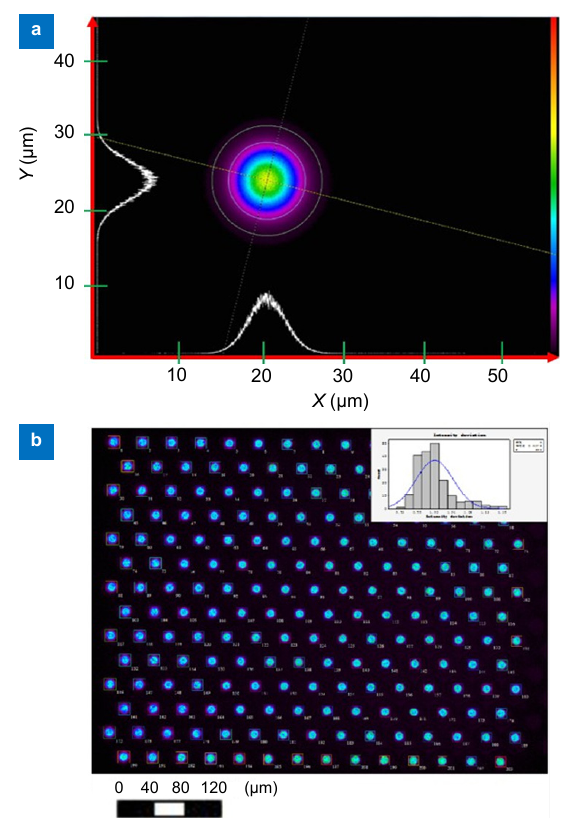
Fig. 12 | ( a ) Far-filed pattern with 6 μ m aperture. ( b ) Intensity distribution under 1 A pulse of 2-D